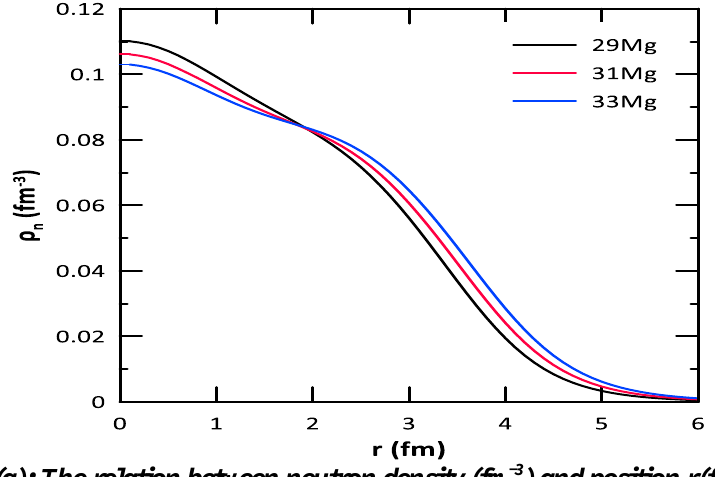
Fig. 6(a): The relation between neutron density (fm -3 ) and position r(fm) for 29,31,33 Mg nuclei.